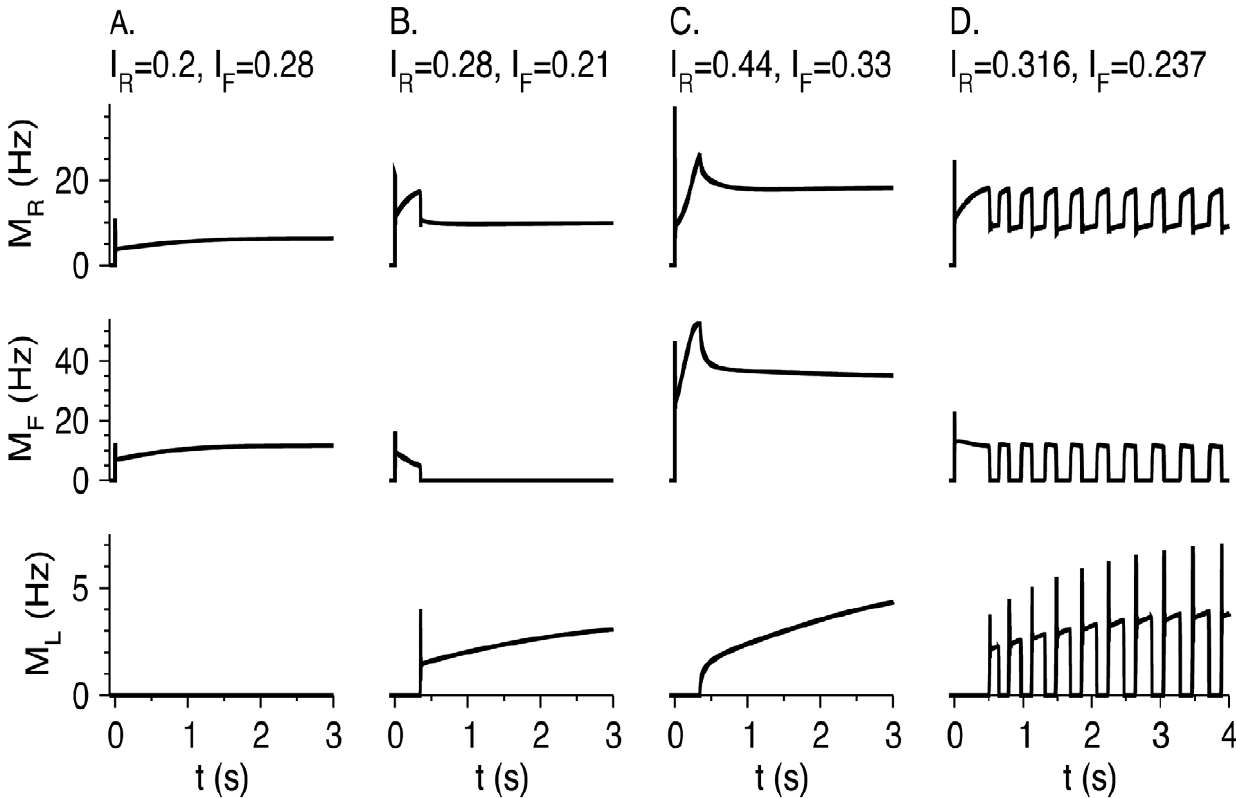
Figure 11. Response of the RS-LTS-FS network to step inputs I R H ( t ) and I F H ( t ) to the RS and FS neurons. Parameters are listed in Table 2. Time courses of M R (top panels), M F (middle panels) and M L (middle panels) are plotted. (A) I R =0.2, I F =0.28. M L =0 for all times. (B) I R =0.28, I F =0.21. M F =0 for large t . (C) I R =0.44, I F =0.33. M F and M L are non-zero for large t . (D) I R =0.316, I F =0.237. The network oscillates at large t . RS neuron oscillate between a more active state and a less active state. FS neurons fire during the more active state of RS neurons, and LTS neurons fire during the less active state of RS neurons.